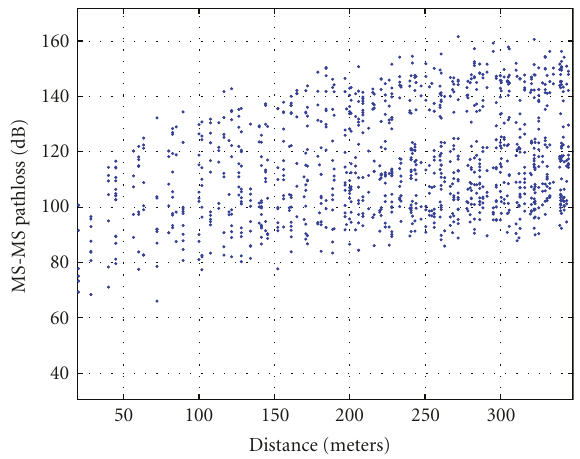
Figure 6: MS to MS pathloss versus distance.